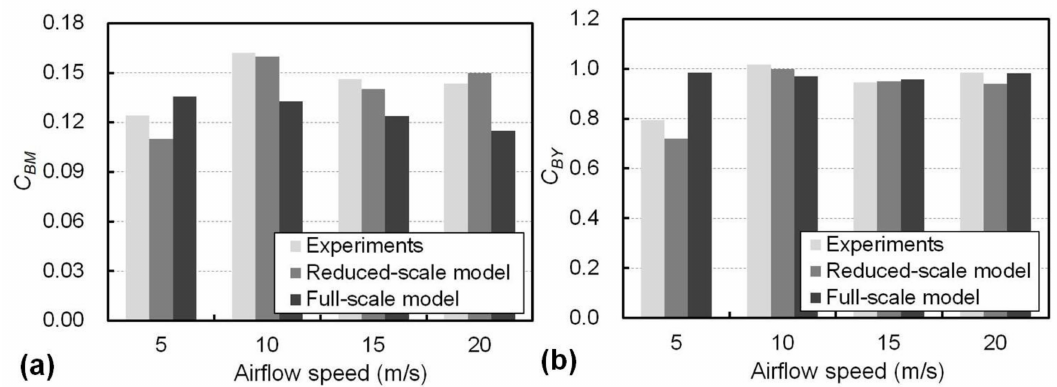
Figure 12. E ff ects of the airflow speeds on ( a ) C BM and ( b ) C BY . based on the wind tunnel experiments and